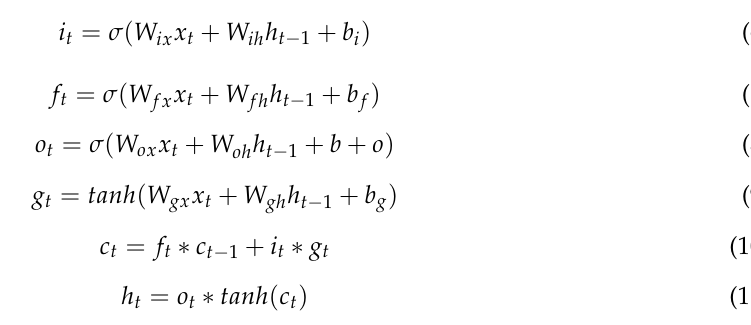
Figure 7. Three types of LSTM inferences.